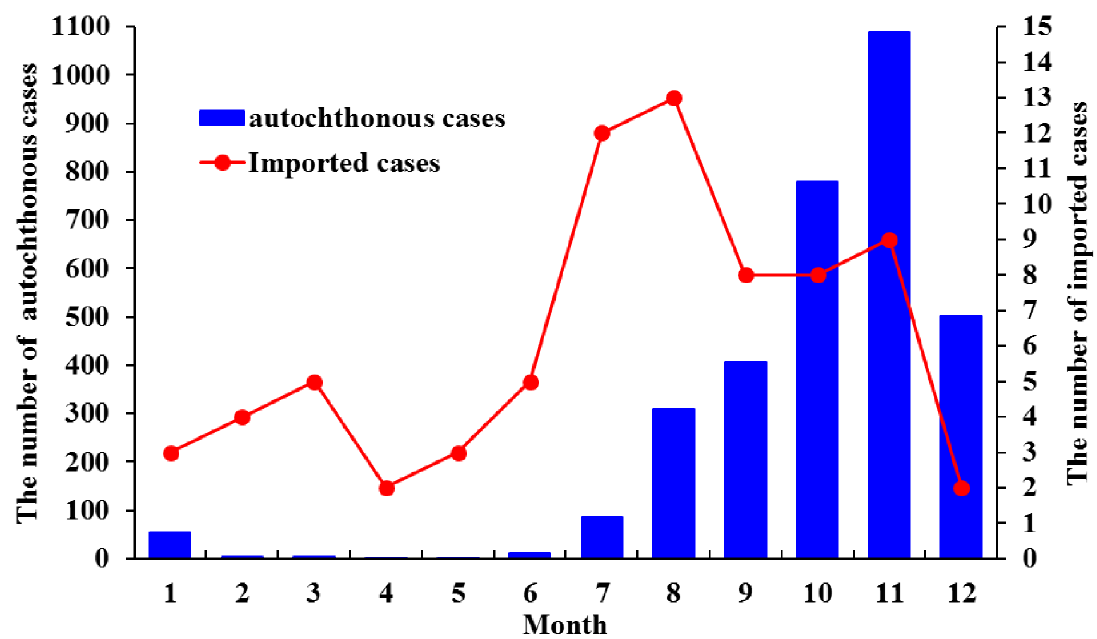
Fig 2. The number of autochthonous and imported dengue patients per month in Kaohsiung City, Taiwan during 2007–2011.